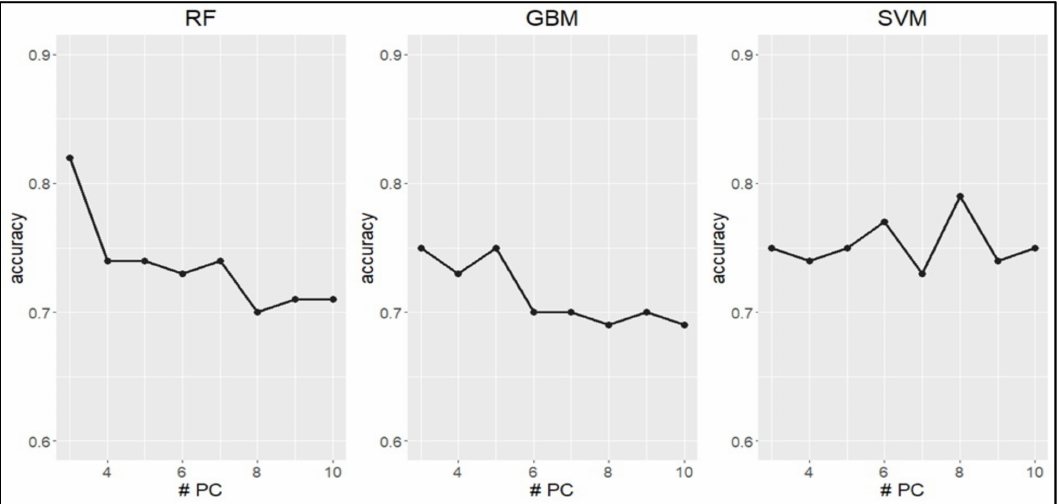
Figure 3. Accuracy of the models, estimated through the use of 3 to 10 PC as input data. RF: Random Forest; GBM: gradient boosting machine; SVM: support vector machine; PC: principal component.